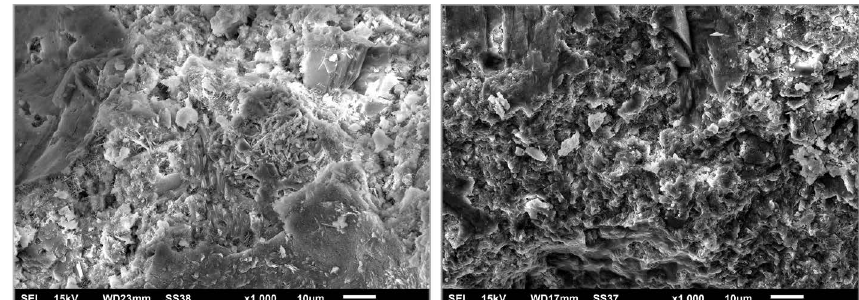
Figure 14. Morphology of samples of concrete cured for 28 days (left) and after the exposure to 40 cycles